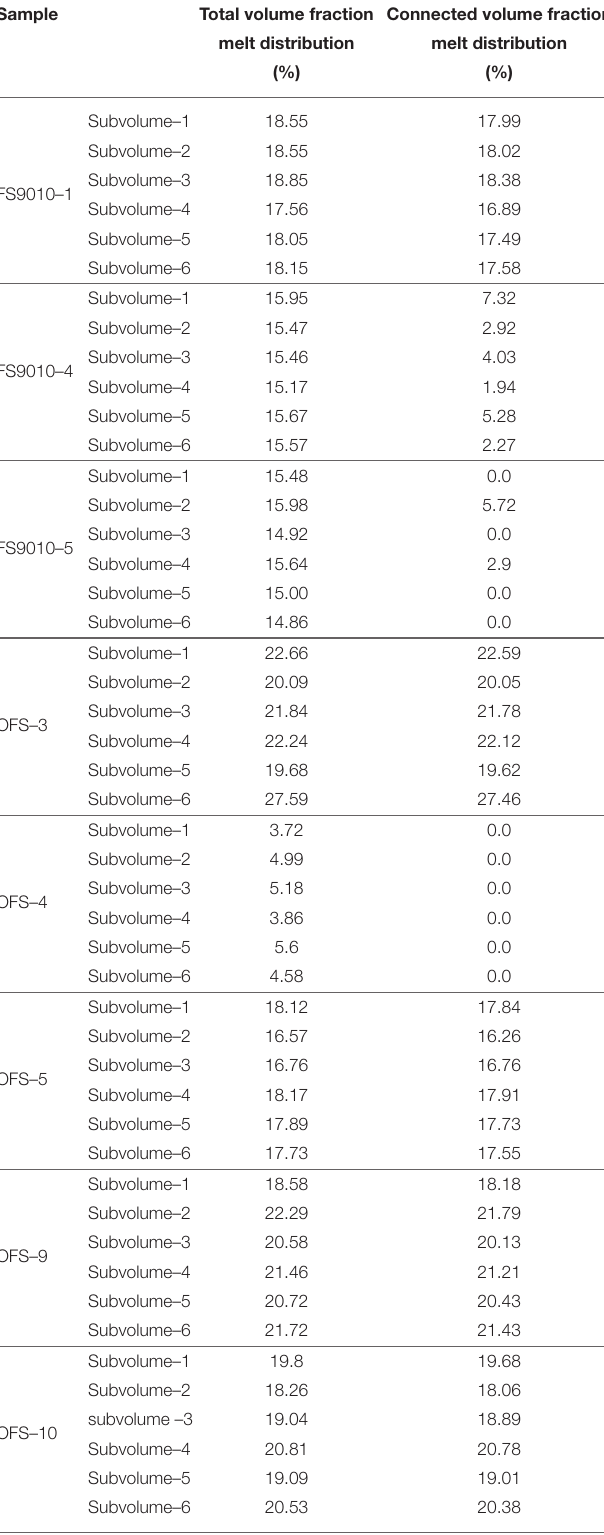
TABLE 2 | Results of melt distribution volume